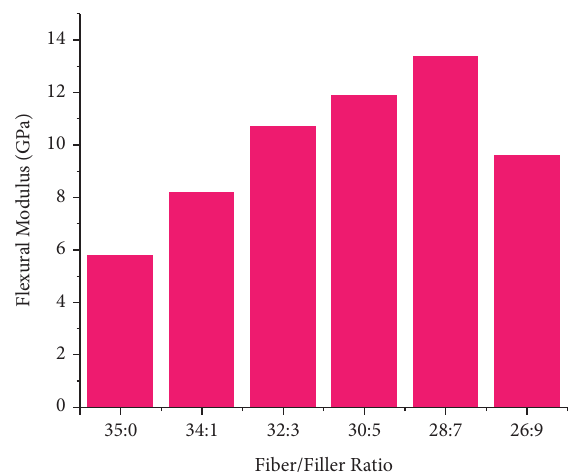
Figure 9: Equivalent flexural modulus of epoxy resin/madar fibre and sugarcane bagasse ash composites with different percentages of fibre/filler